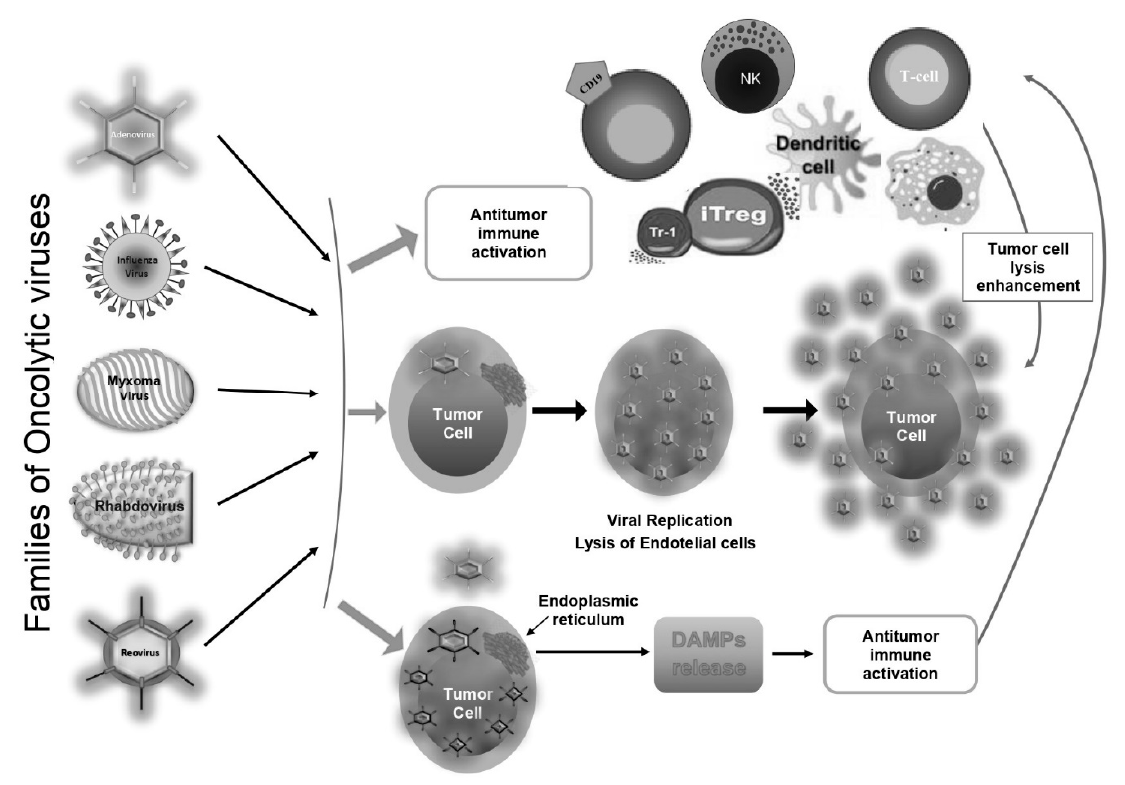
Figure 1. Some mechanisms of action of Oncolytic Figure 1. Some m echanisms of action of Oncolytic viruses.